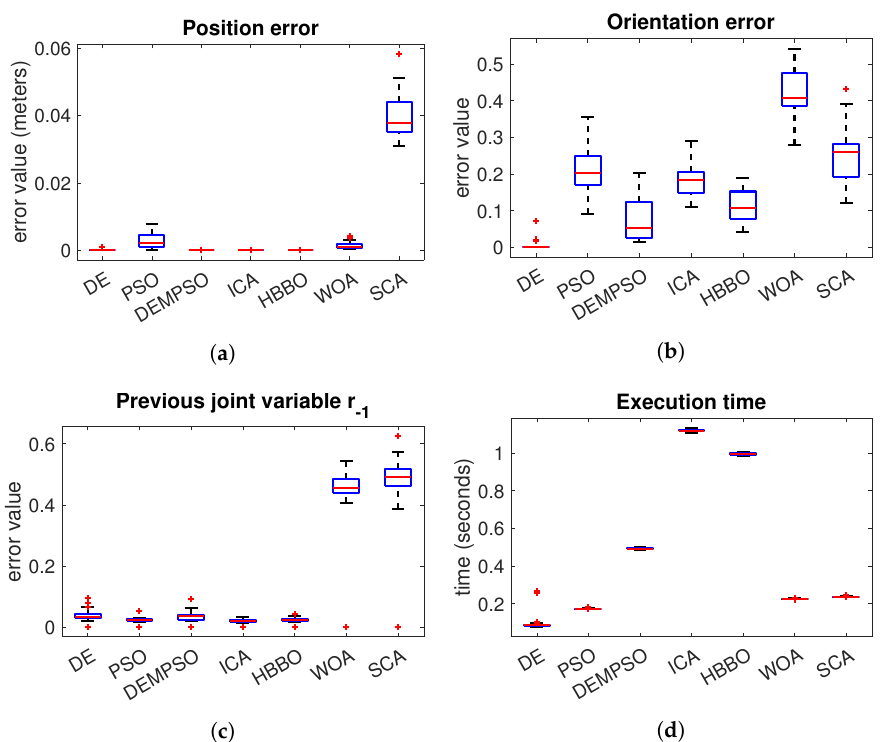
Figure 7. Circle path tracking results with the Baxter robot. ( a ) Baxter end-effector position error (5); ( b ) Baxter end-effector orientation error (15); ( c ) Baxter joint variables error (16); ( d ) Execution time for each point in the path. Table 5. Position error comparative results for the circle